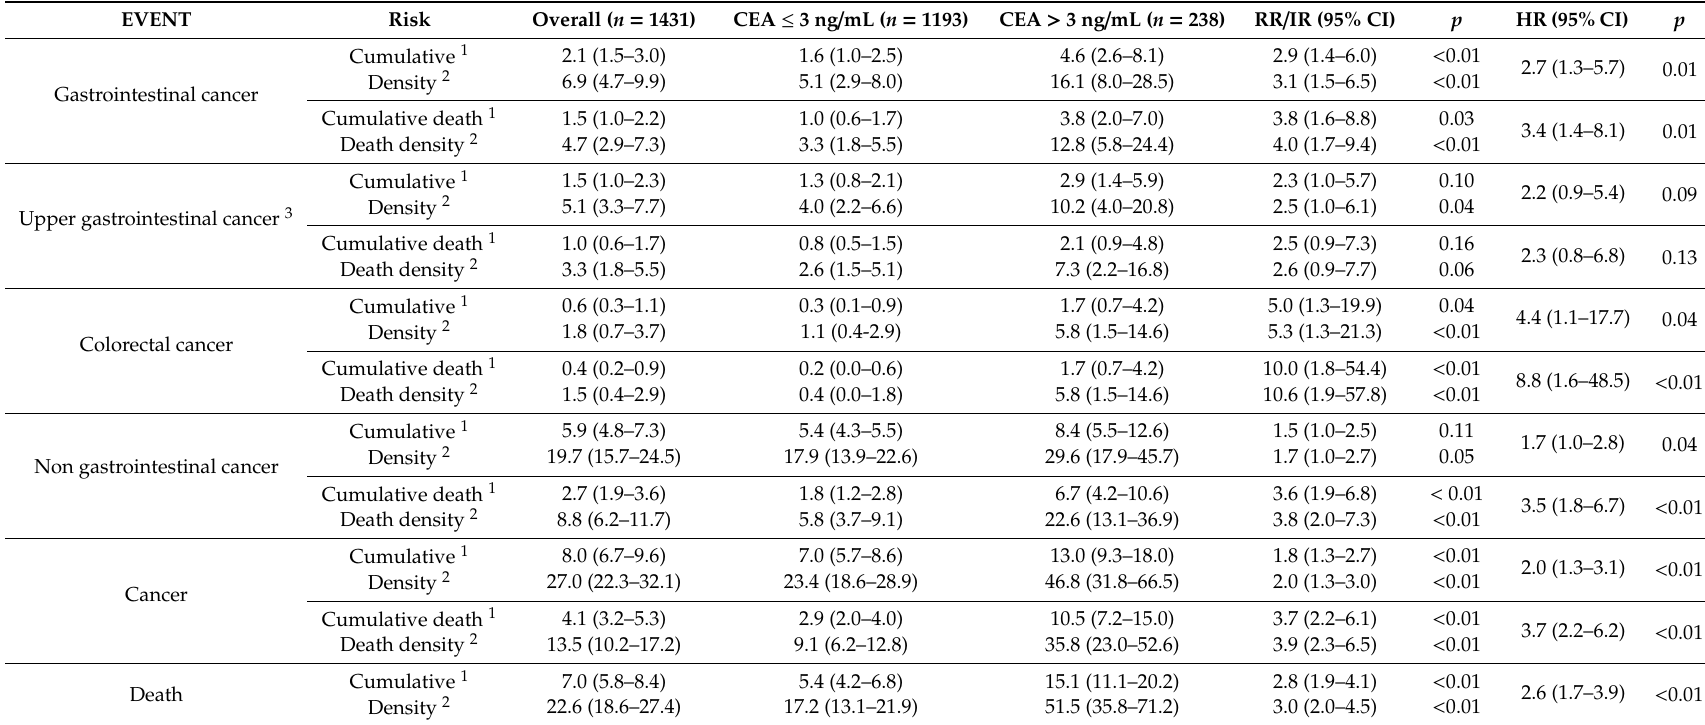
Table 2. Risk of cancer and death according to the carcinoembryonic antigen